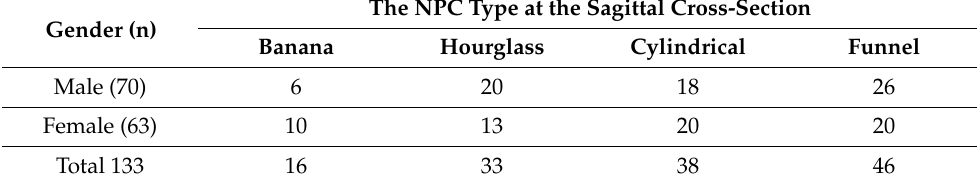
contrast, the A-P diameter of an incisive foramen in funnel NPC type (Figure 4C) was significantly above the values observed in the cylindrical type ( p < 0.05). Table 1. NPC type distribution according to gender.